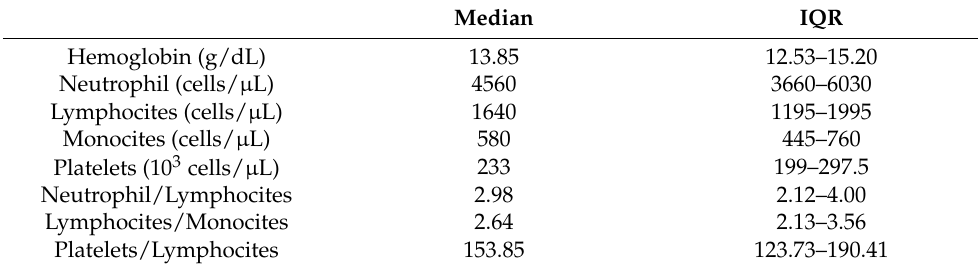
Table 2. Summary of blood values for the whole